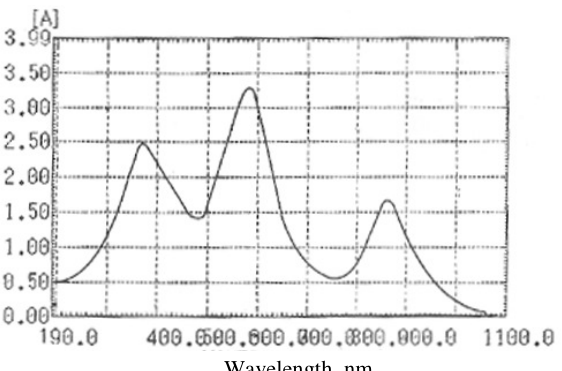
Figure 2. Electronic spectrum of Co(II) chloro complex